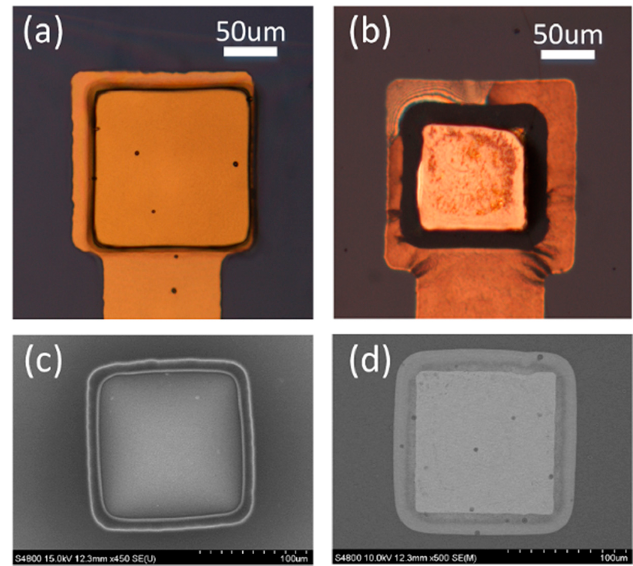
Figure 7. Optical and SEM images of a recessed electrode and a plateau electrode. ( a ) Enlarged image of the recessed electrode obtained using an optical microscope. Metal wires can be seen to pass under the PDMS film. ( b ) Plateau electrode. The dark band shows the PDMS slope connecting the electrode and wire. ( c ) SEM image of recessed electrode. The inclined holes can be observed on the PDMS film. ( d ) SEM image of plateau electrode.